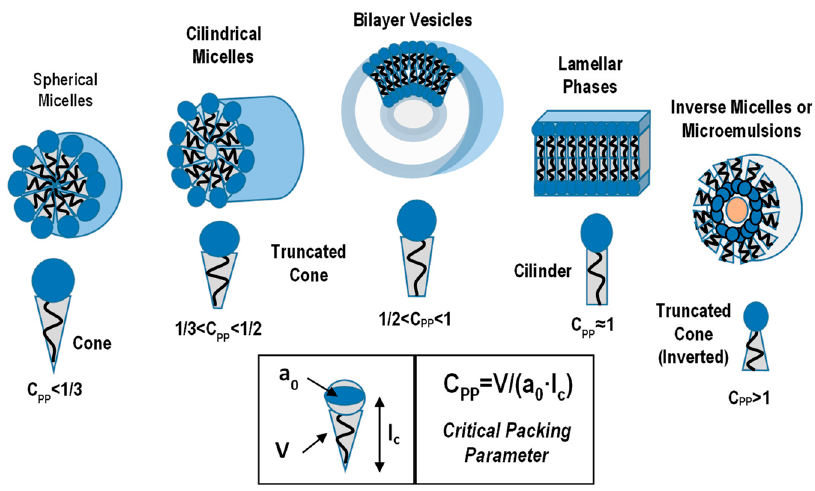
Figure 2. Amphiphile aggregates morphology and analysis of the critical packing parameter Cpp.